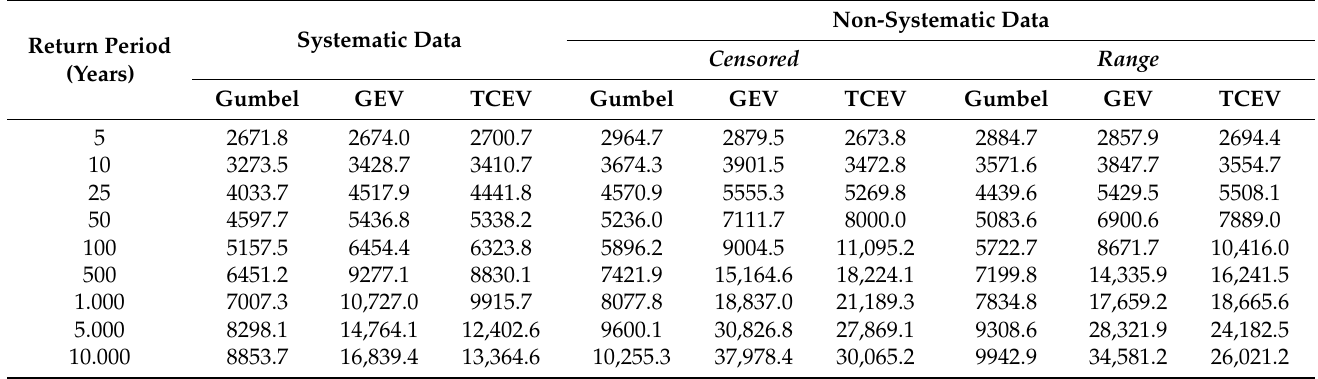
Table 1. Flow frequency analysis (FFA) from systematic and non-systematic data in Mocuba city (Mozambique).